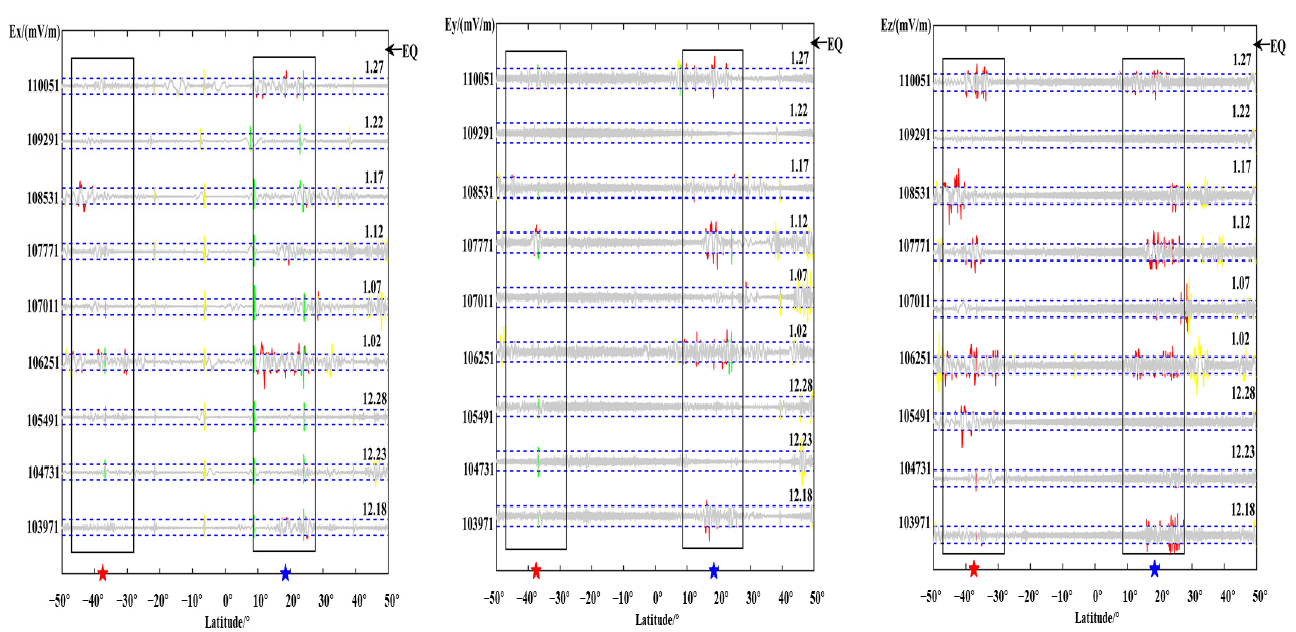
Figure 8. Orbit 109,901 and its revisited tracks.